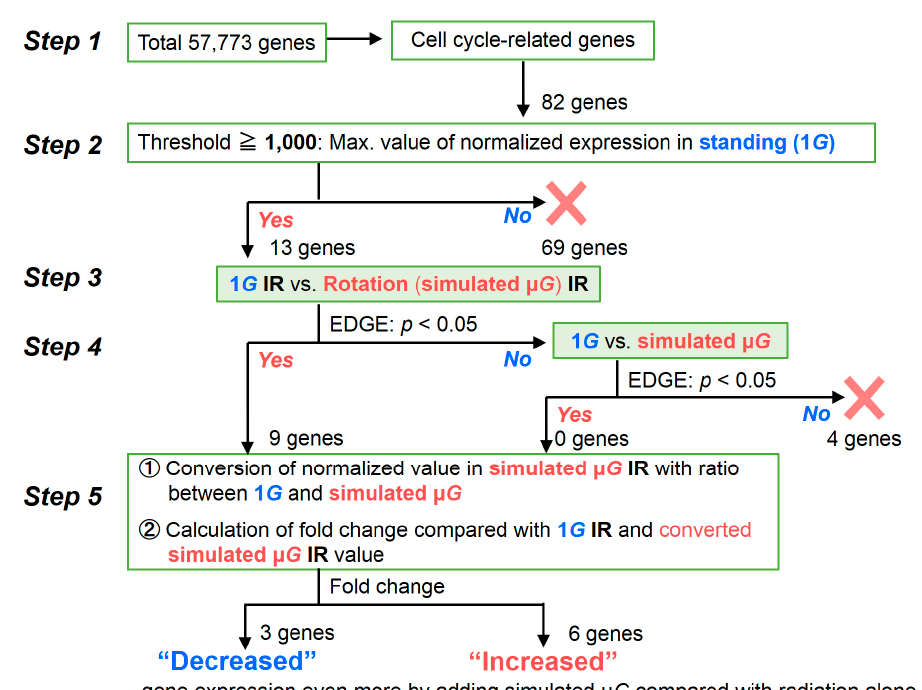
Figure 2. Criteria for identifying genes whose expression levels are different in 1BR-hTERT human fibroblasts when they are exposed simultaneously to radiation and simulated μ G vs. when exposed to radiation alone. To narrow down the number of target genes from the total of 57,773 genes, cell cycle-related genes were selected in Step 1. In Step 2, the threshold was set as when the maximum normalized expression value of standing (1 G ) condition was 1000 or more. The normalized expression values of each condition were calculated by CLC Main Workbench software. If this threshold was exceeded, Step 3 involved comparing the simulated μ G effect between irradiated samples: normalized expression value of irradiated standing 1 G samples vs. simulated μ G irradiated samples. If Step 3 showed a significant difference (EDGE; p < 0.05) between without and with simulated μ G , the analysis proceeded to Step 5. If no difference was noted in Step 3, these genes proceeded to Step 4 for judging the simulated μ G effect alone: comparison of expression values of 1 G non-irradiated samples vs. rotation simulated μ G condition non-irradiated samples. When genes passed this step (EDGE; p < 0.05), they were sent to Step 5 for the calculation of fold change while considering the simulated μ G effect alone.